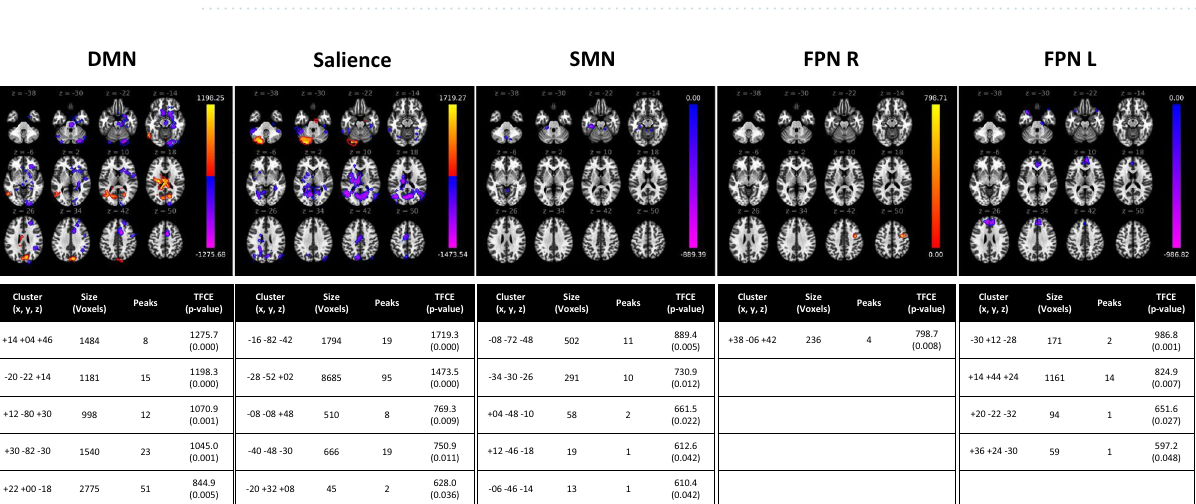
Figure 4. Significantly decreased (cool colours) ROI-to-ROI connectivity in males with concussion in comparison to healthy male controls.